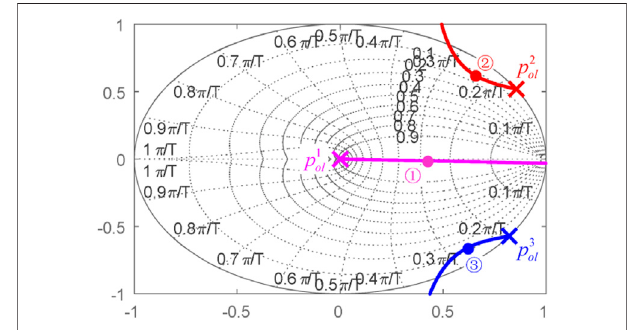
FIGURE 9 | Pole distribution of the equivalent plant in the SRF for K (cid:1) K opt .